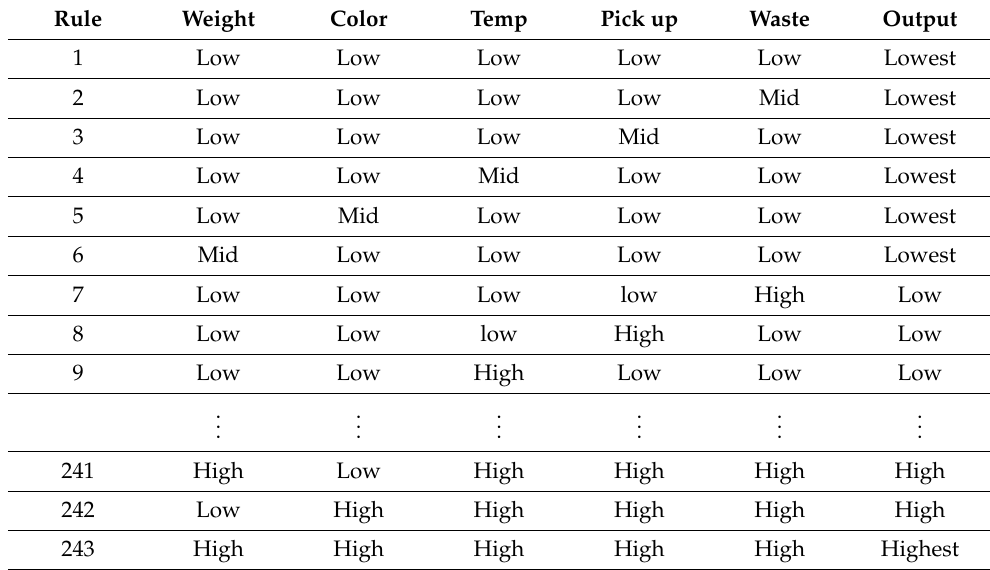
Table 11. The Fuzzy rules for the five responses.